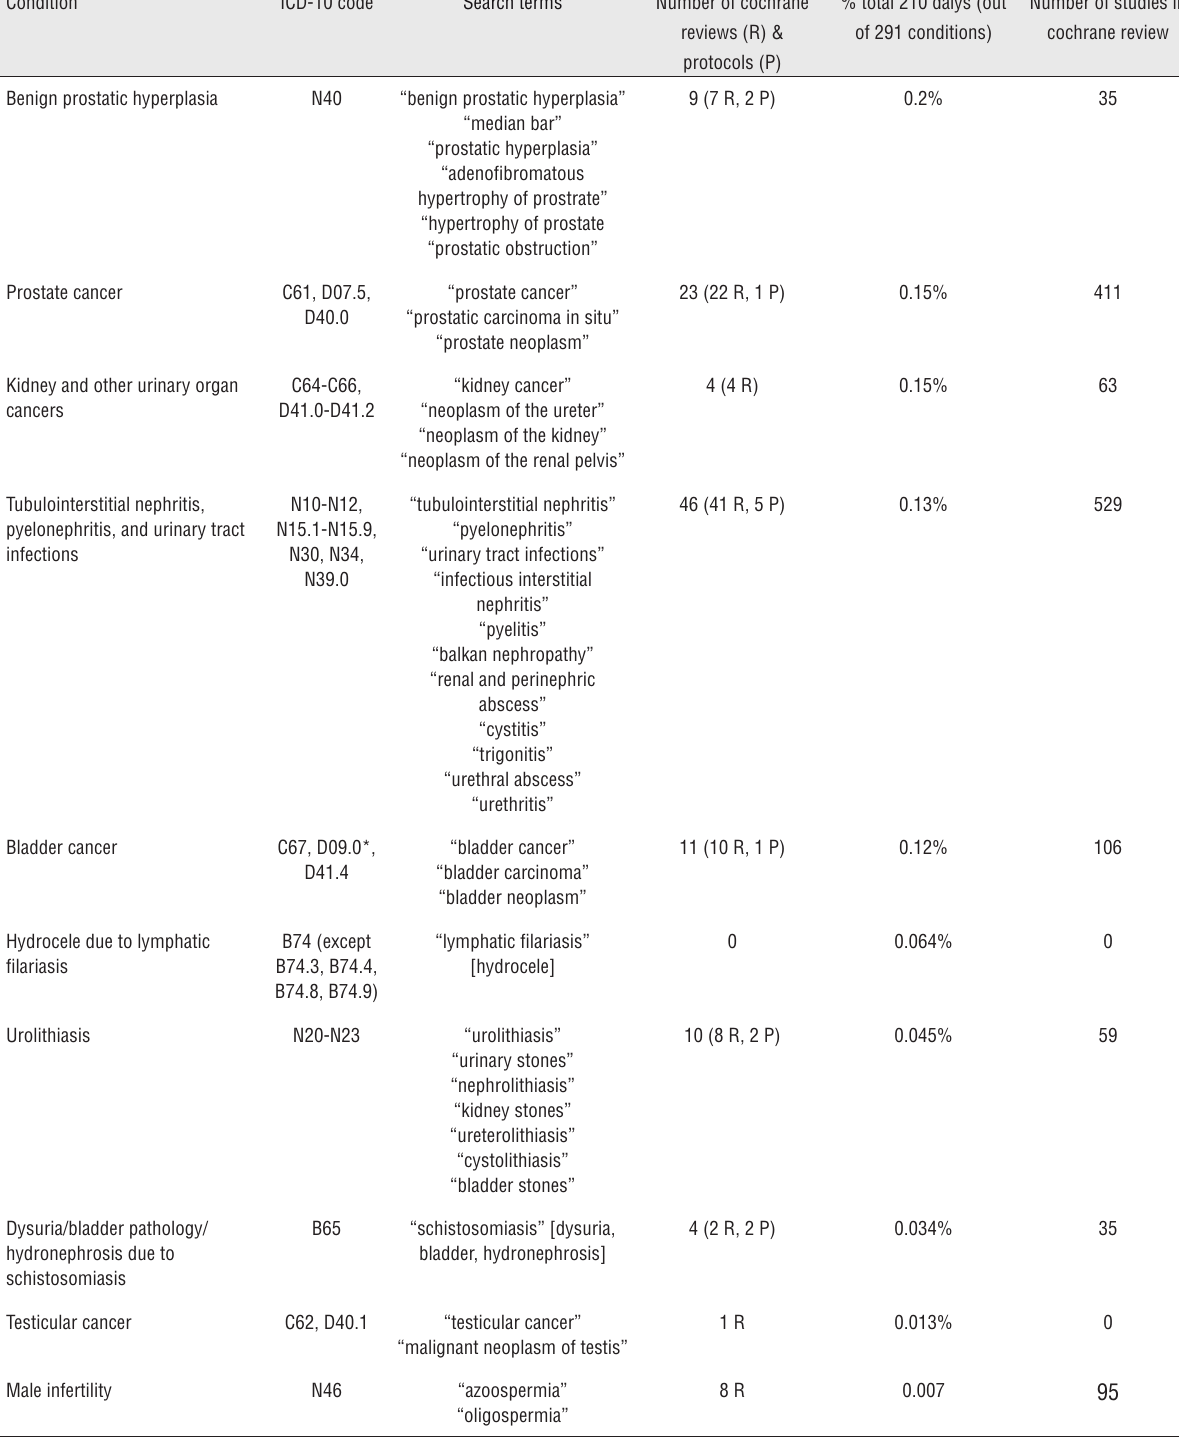
Table 1 - Men’s health and urologic diseases studied by GBD 2010 with corresponding ICD-10 codes, search terms, number of systematic reviews (R) and protocols (P) in CDSR, percent of total DALYs (arranged in order of decreasing % of total DALY), and number of studies included in Cochrane